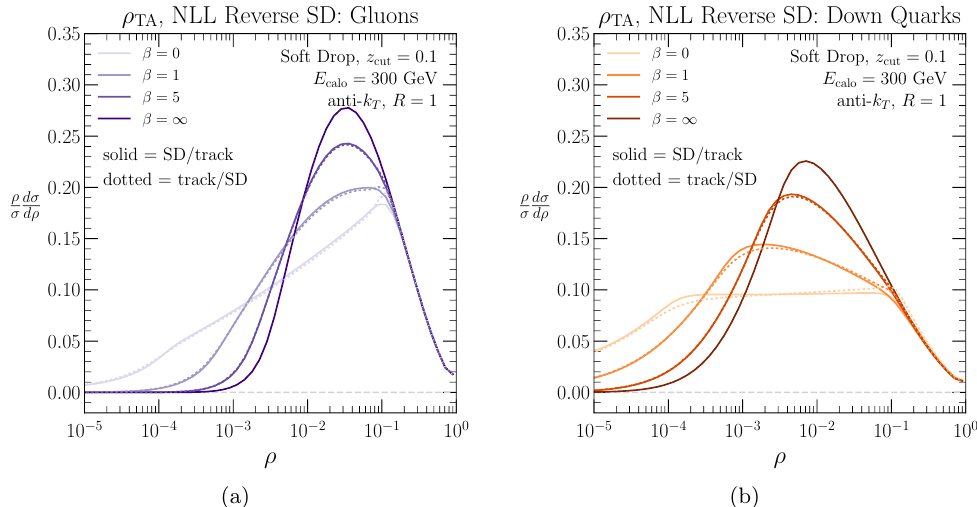
Figure 22 . Comparison between track-assisted mass with soft-drop grooming for (a) gluon jets and (b) down-quark jets. The solid curves were computed by (cid:12)rst grooming the jet and then restricting to charged particles. The dotted lines were computed by reclustering only the charged particles and then